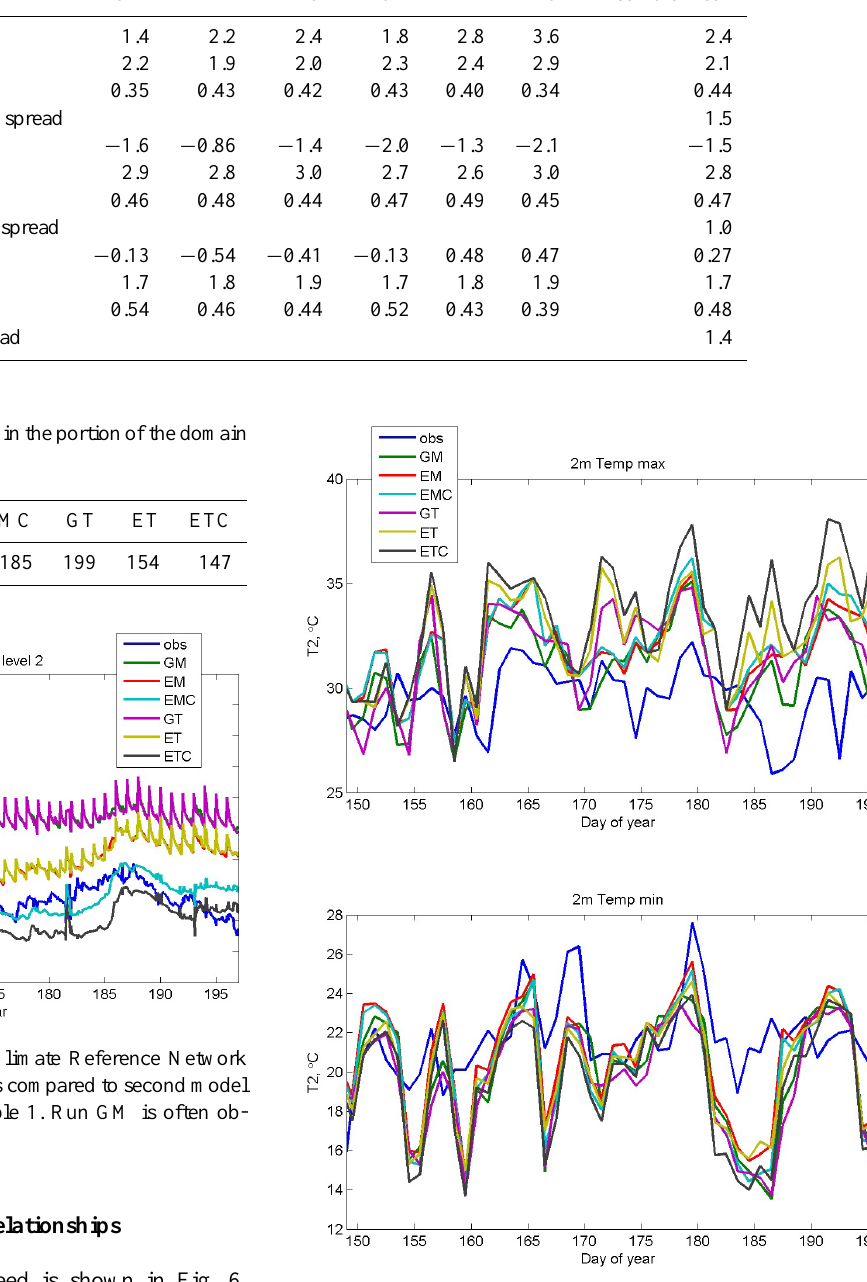
spread (maximum minus minimum value). If the spread is not explicitly qualified as 2 / 3 or full, the 2 / 3 spread is